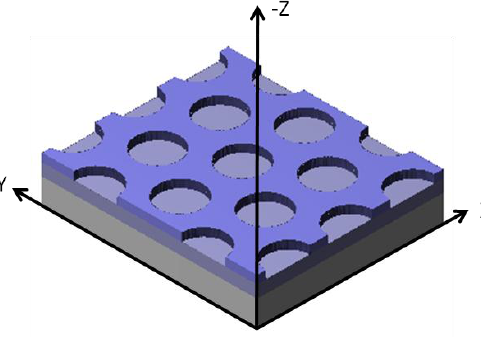
and R (and T x y x